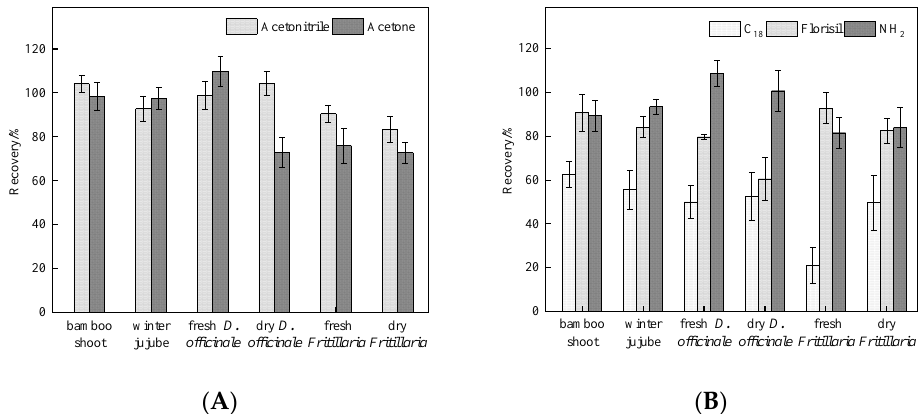
Figure 1. Effects of ( A ) type of extraction sorbent and ( B ) type of solid-phase extraction cartridge used in the recovery of imidacloprid from the bamboo shoot, winter jujube, fresh and dry D. officinale , and fresh and dry Fritillaria samples spiked at 0.1 mg·kg −1 ( n = 3).